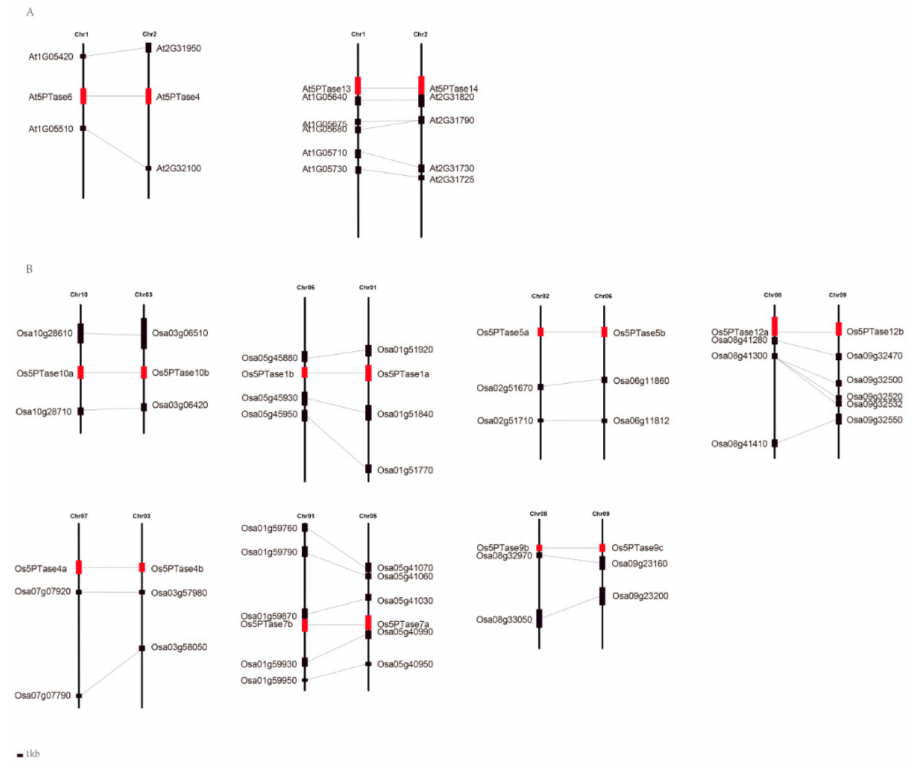
Figure 6. Collinearity analysis of duplicated 5PTase gene pairs. At, Arabidopsis thaliana ; Os, Oryza sativa . The syntenic paralogous genes are connected by lines. Table 1. Divergence between 5PTase gene pairs in